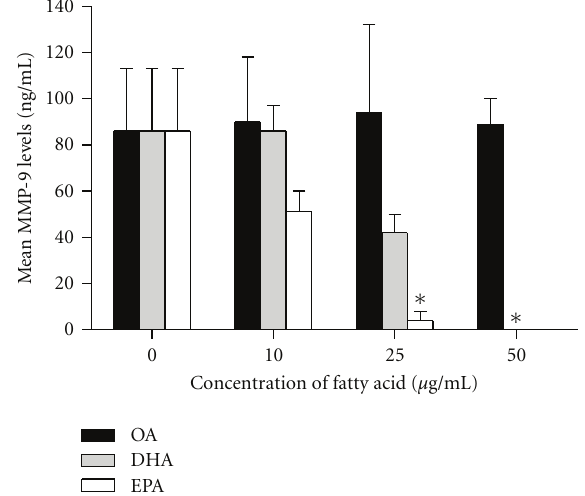
Figure 2: Mean MMP-9 activity from PBMC supernatants. PBMC from three di ff erent normal controls. MMP-9 activity from supernatants of ConA-stimulated PBMC is decreased following treatment with DHA and EPA when compared to an untreated ConA-stimulated PBMC control (100% MMP-9 activity). OA served as an oil control and showed no significant decrease in MMP-9 levels at any concentration. PBMC were pretreated for 2hr in the presence of 10, 25, and 50 μ g/mL of one of the following, DHA, EPA, or OA. Cells were then stimulated with ConA and supernatants were collected to determine MMP-9 activity by gelatin substrate zymography. Error bars represent SE. ∗ Significant decrease compared to control ( P ≤ 0 .